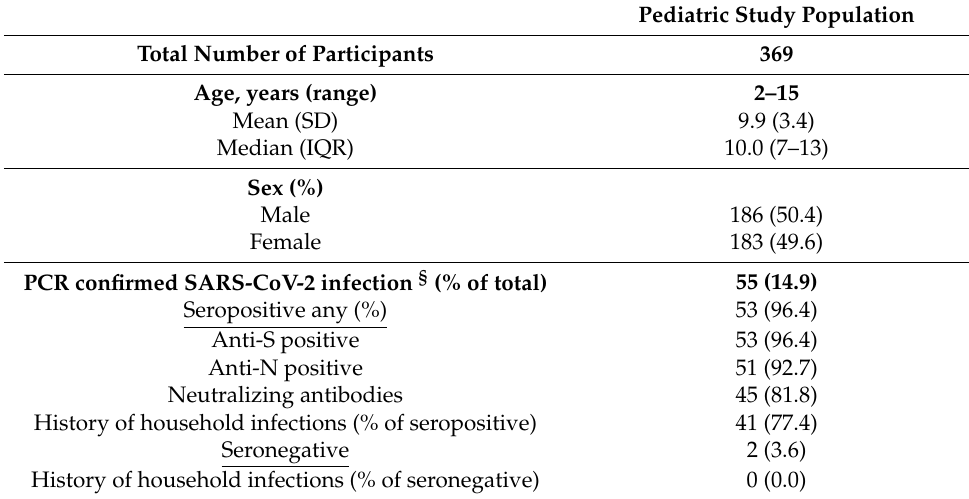
Table 1. Baseline characteristics and serostatus of